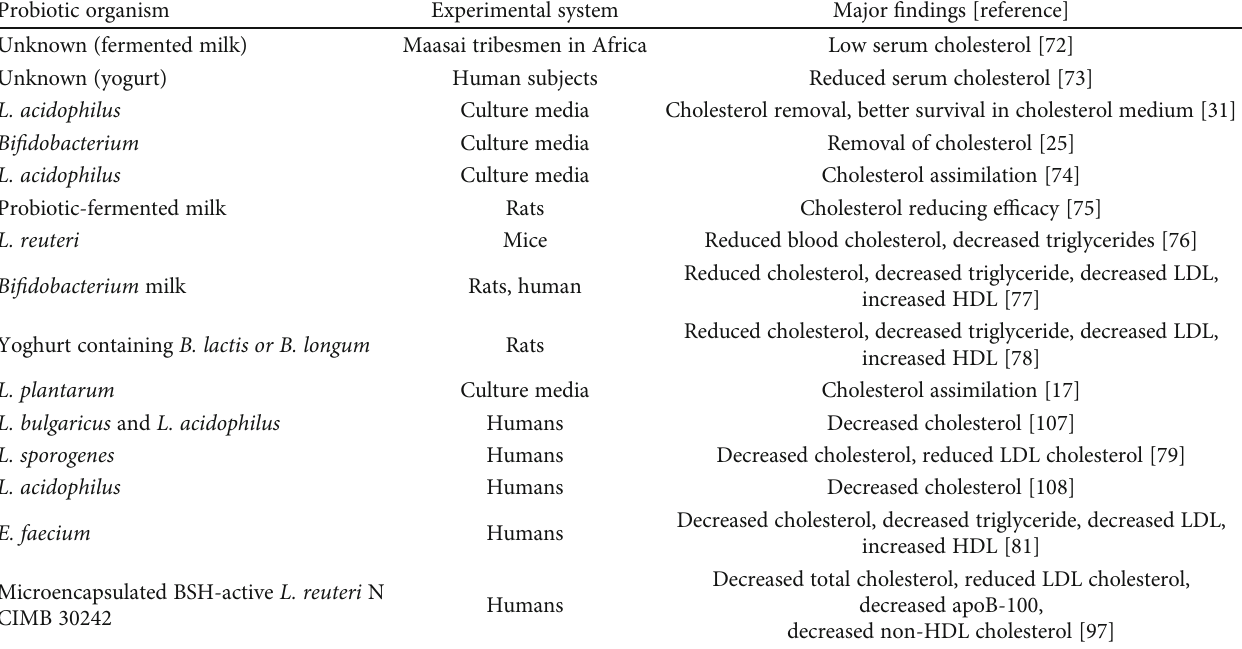
Table 2: Summary of major fi ndings for probiotic mediated cholesterol